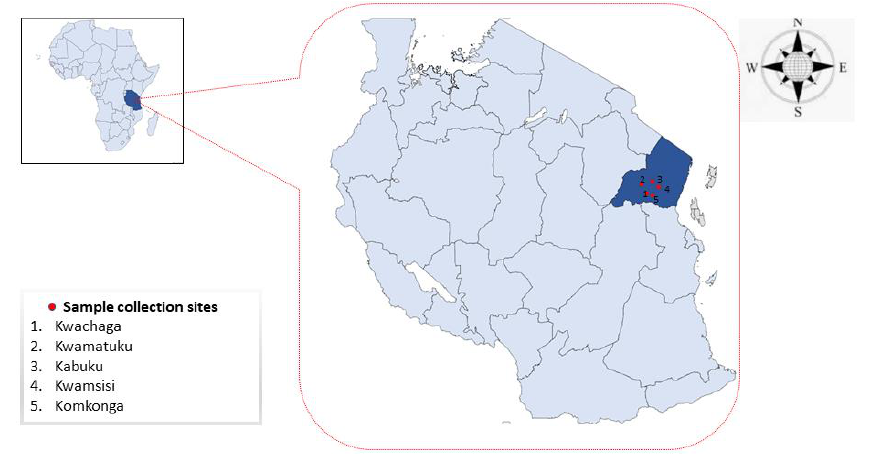
Figure 1. Map of Tanzania showing the sample collection sites.